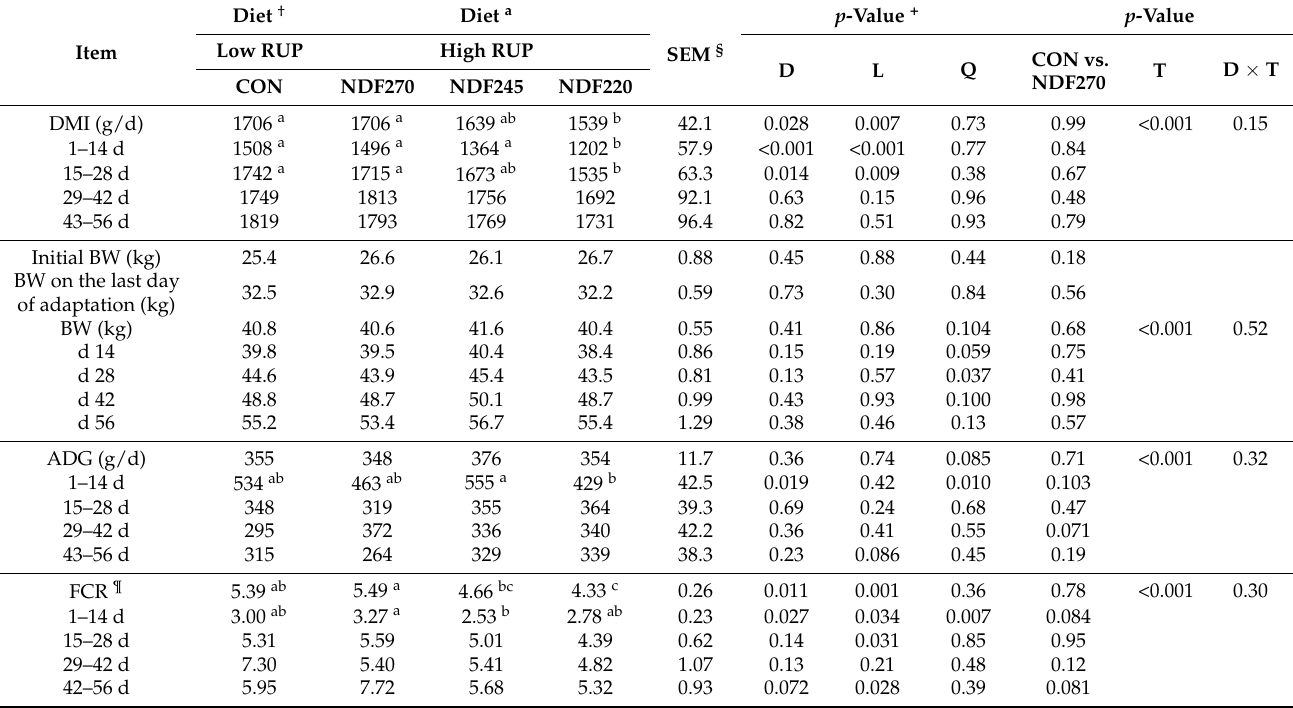
Table 2. Dry matter intake (DMI), body weight (BW), average daily gains (ADG), and feed conversion ratio (FCR) in lambs fed diets with different levels of neutral detergent fiber (NDF) and rumen undegradable protein (RUP).